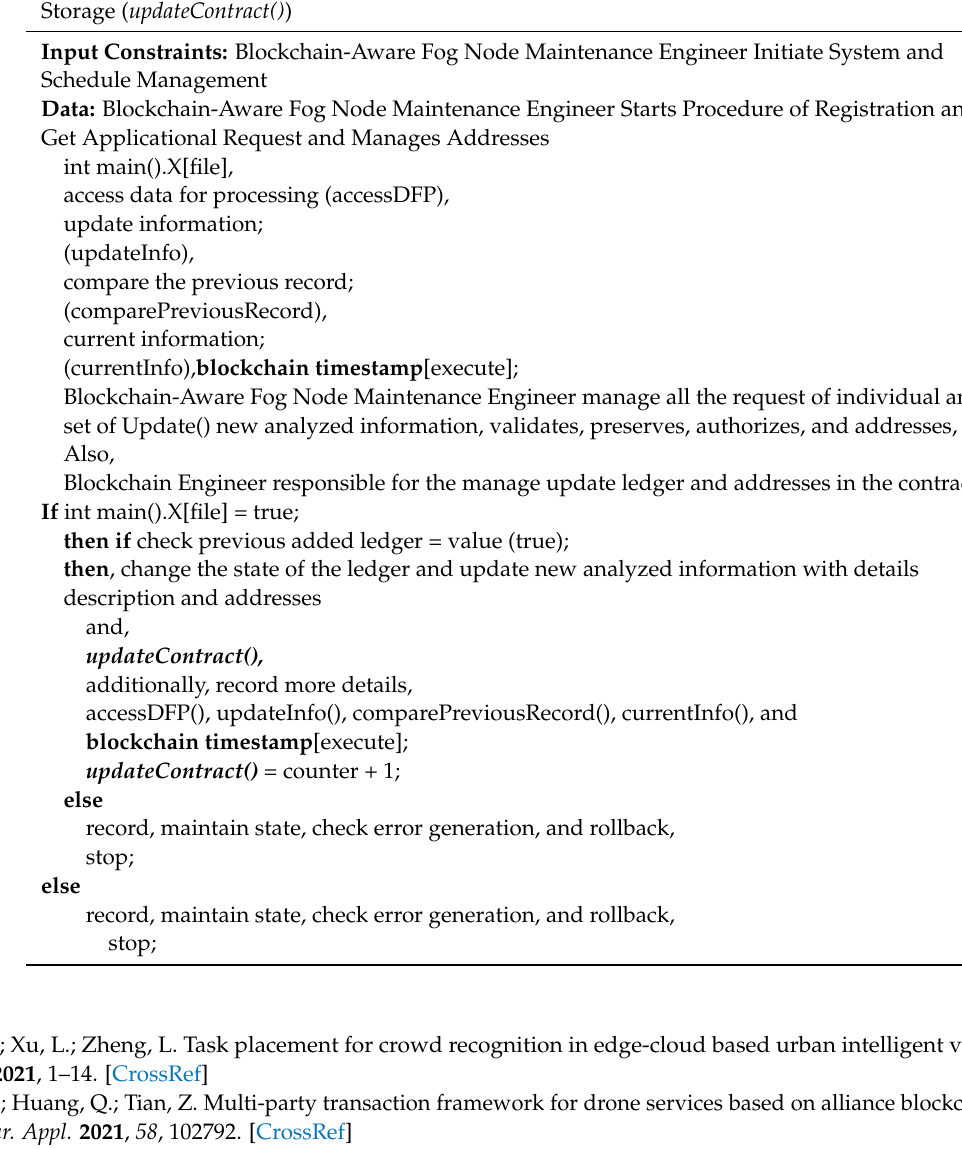
Algorithm A3. After Investigational Process and Analysis of Drone-Based Captured